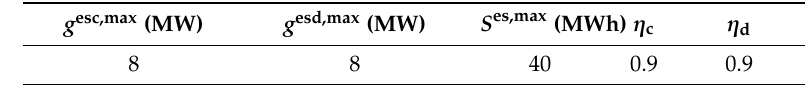
Table A3. Parameters of the ESS.